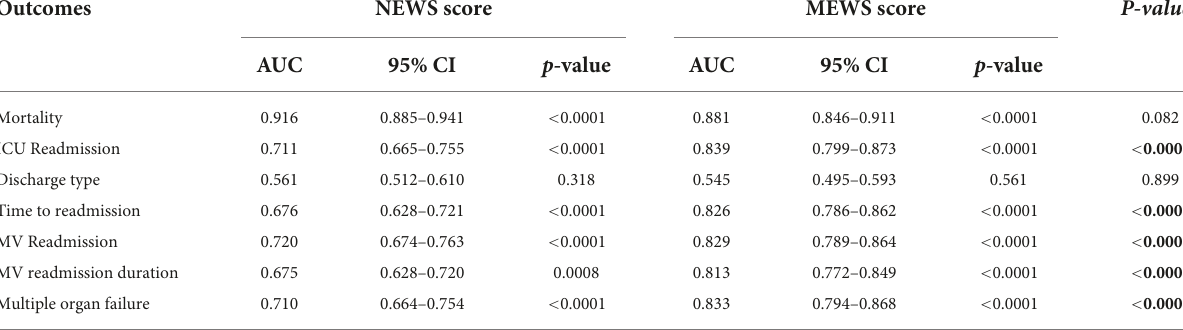
TABLE 7 Comparison of ROC curves between NEWS and MEWS scores to predict